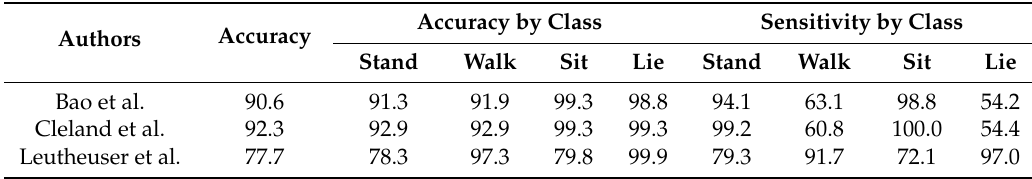
Table 7. Accuracy and sensitivity by class for all SOA systems for PAC in the in-lab training/out-lab testing